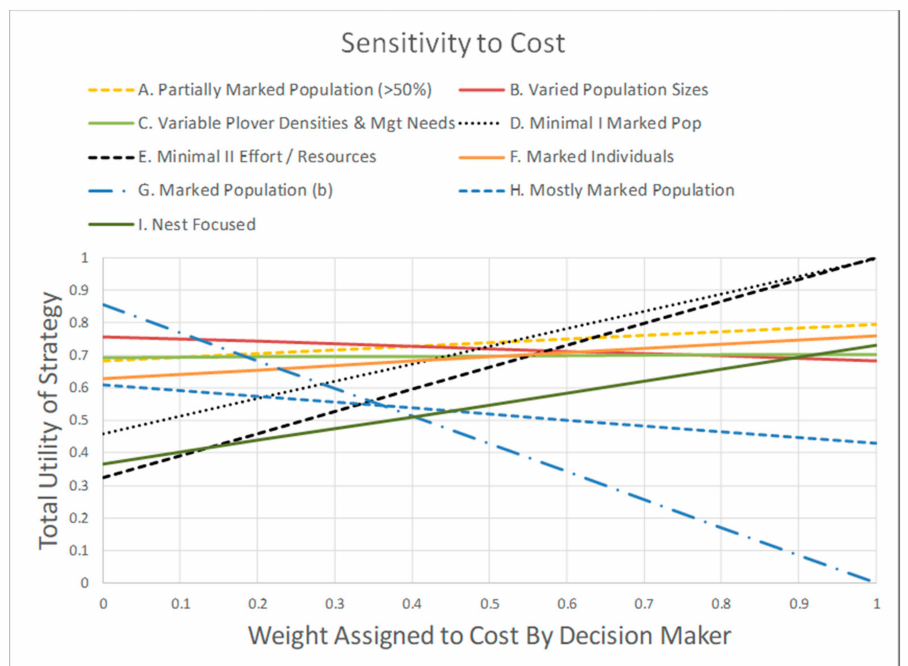
Figure 7. Sensitivity of total utility to the weight assigned to the cost objective. This analysis is for a moderately risk averse decision maker (as specified in Supplementary Materials 6). If cost receives a weight between approximately 0.15 and 0.45 (x-axis), the preferred monitoring strategy is “B. Varied Population Sizes”. Outside this range, the preferred monitoring strategy was either “G. Marked Population (b)”, when the weight assigned to cost is < 0.15, or “D. Minimal I Marked Population”, when the weight assigned to cost is >0.45. The choice of strategy B was thus robust over a relatively large range in the weight assigned to the cost